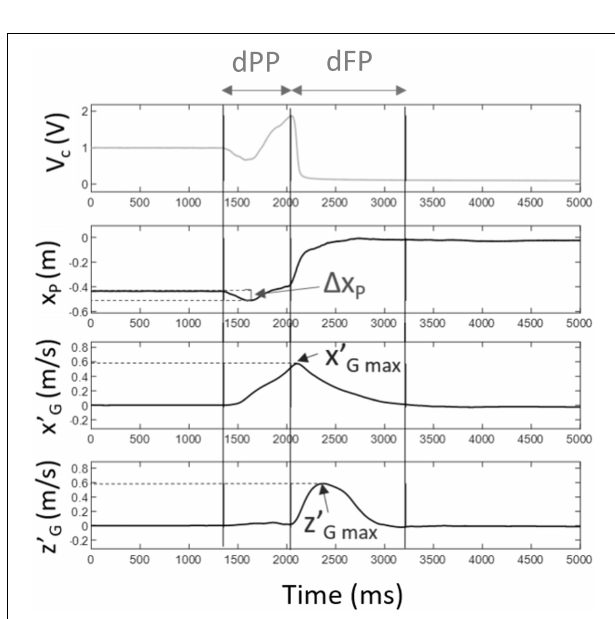
FIGURE 4 | STS indicators. V sensor represents the pressure sensor beneath the seat; x p the position of the CoP, x (cid:48) G the anterioposterior velocity of the CoG; z’ G the CoG vertical